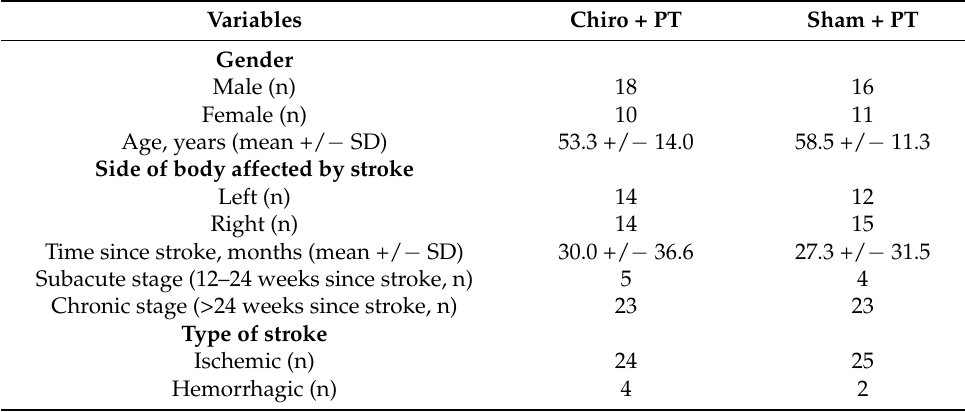
Figure 1. CONSORT study flow diagram. Table 1. Clinical characteristics of participants in each